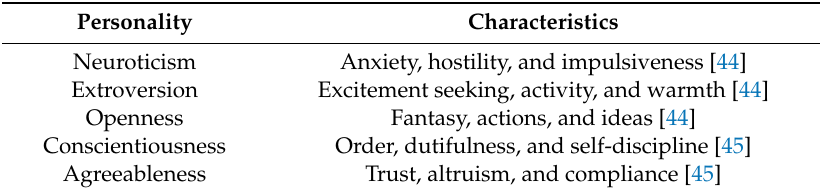
Table 1. Big five personality and corresponding